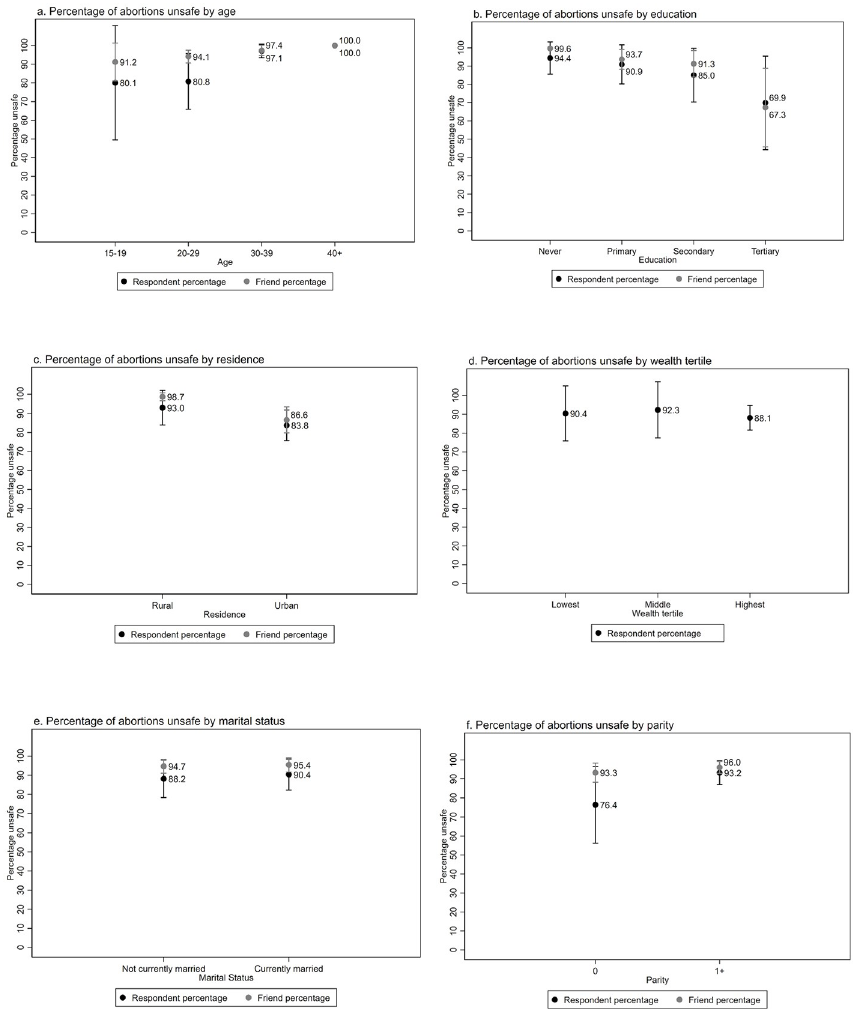
Fig 2. Percent of induced abortions that were unsafe among female respondents aged 15 to 49 and their closest female friends aged 15 to 49 in Burkina Faso by background characteristics.